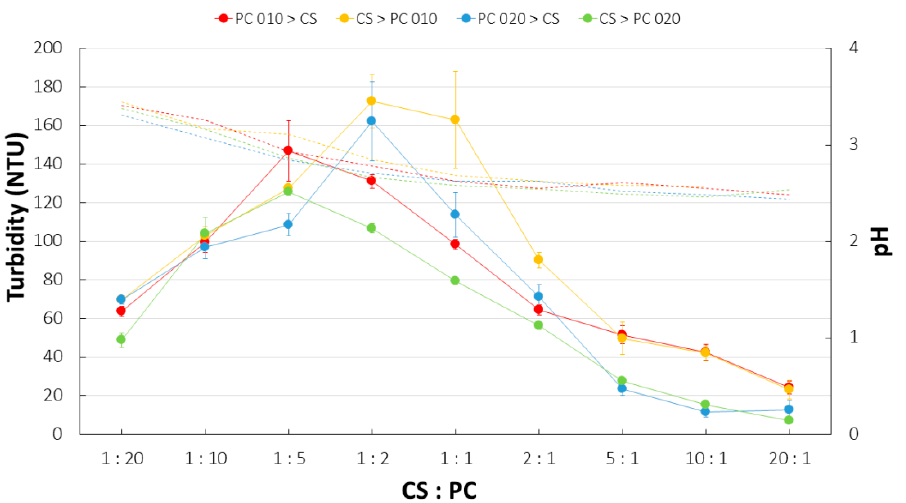
Figure 8. Turbidity (continuous line) and pH fluctuations (dashed line) recorded for CS/PC mixtures with different polymer ratio, polyelectrolyte deposition, and PC type (mean ± SD, n = 3).